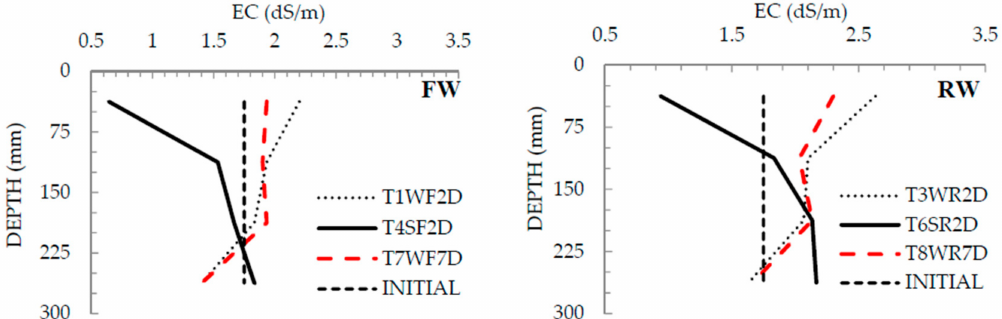
Figure 5. Soil salinity (EC) at different soil depths for fresh water (FW) treatments ( left ) and recycled water (RW) treatments ( right ). See Table 2 for treatment